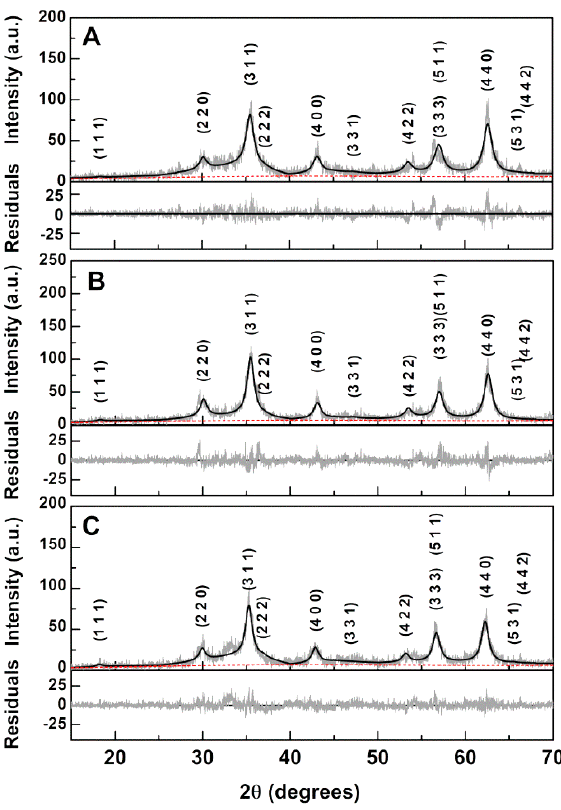
Figure 2. XRD patterns with Miller indices of the synthesized calcium-substituted magnesium ferrite nanoparticles. ( A ): Ca 0.25 Mg 0.75 Fe 2 O 4 ; ( B ): Ca 0.50 Mg 0.50 Fe 2 O 4 ; ( C ): Ca 0.75 Mg 0.25 Fe 2 O 4 . Gray lines: experimental patterns; black lines: fitted patterns; red dashed lines: background. Table 1. Selected Rietveld analysis